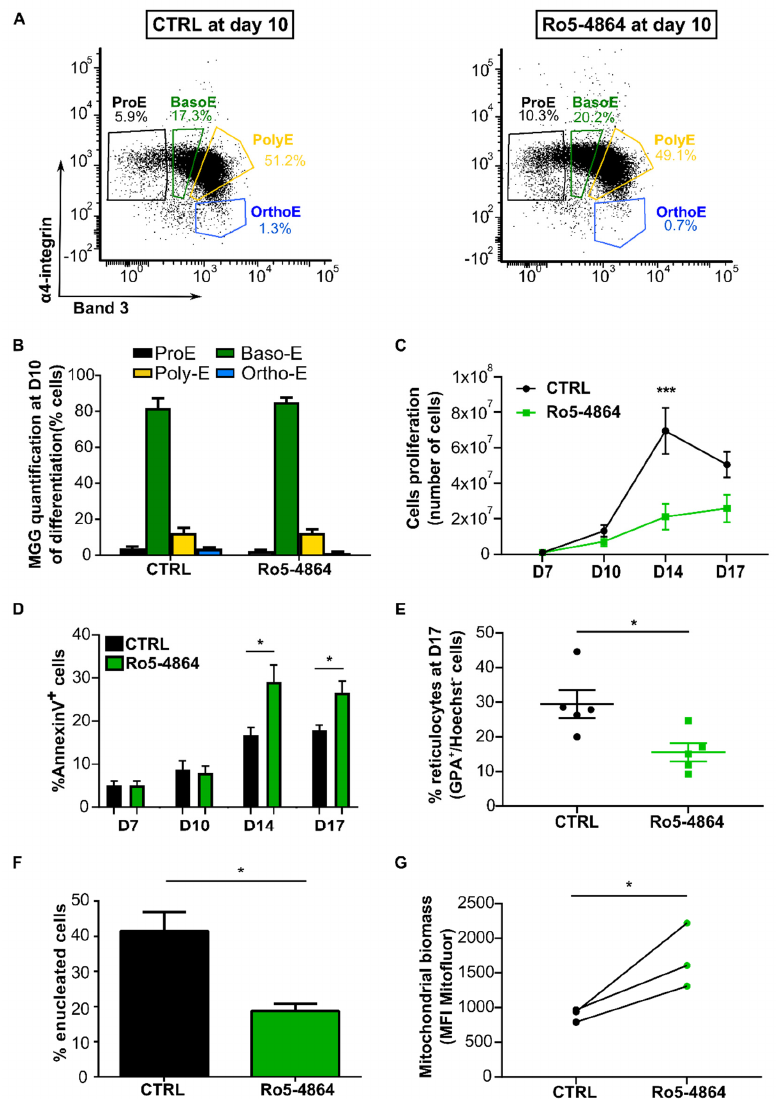
Figure 5. Ro5-4864 recapitulates the phenotypes of TSPO1 shRNA-mediated downregulation. ( A ) Representative profile in flow cytometry of control cells (CTRL) and Ro5-4864 treated cells during terminal erythropoiesis at Day 10. GPA+ cells are gated according to α 4-integrin and Band 3 expression levels to discriminate the different stages of differentiation. ( B ) MGG-based quantification. ( C ) Erythroblast proliferation at Day 7, 10, 14, and 17 ( n = 4). ( D ) Apoptosis assay (annexin V) by flow cytometry at Day 7, Day 10, Day 14, and Day 17 ( n = 4). ( E ) Enucleated cells (GPA+, Hoechst- cells) were quantified by flow cytometry at Day 17 of differentiation ( n = 5) and ( F ) counted after MGG coloration the same day ( n = 3). ( G ) Mitochondrial content of erythroblasts at Day 10 of differentiation detected by flow cytometry (MitoFluor) ( n = 3). * p < 0.05, and *** p < 0.005.